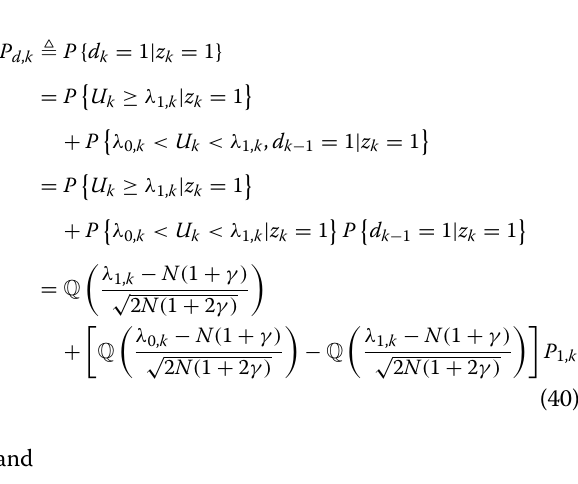
double thresholds are derived with very low complex- ity according to the Neyman-Pearson (NP) test